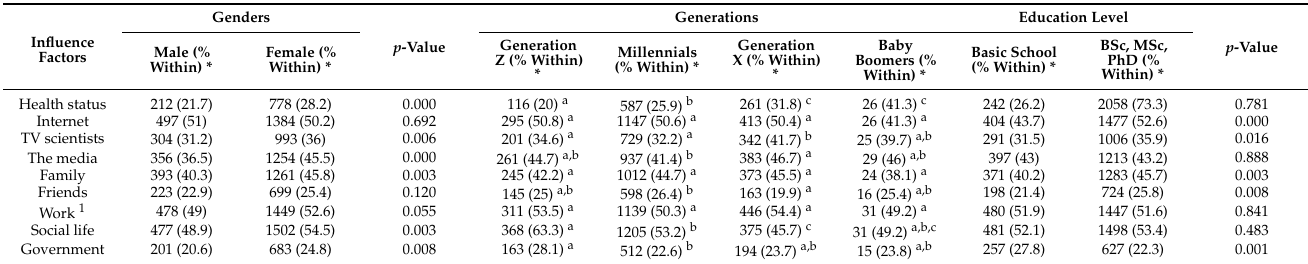
Table 4. Influence factors for Vaccinated participants amongst genders, generations, and education levels, n = 3730.